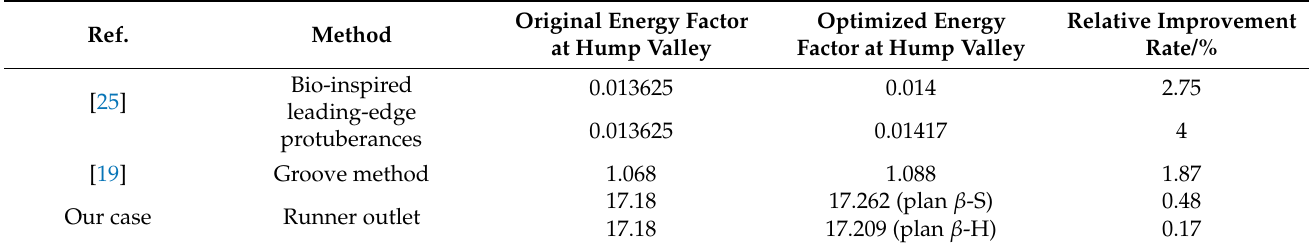
Table 3. Hump characteristics improvement